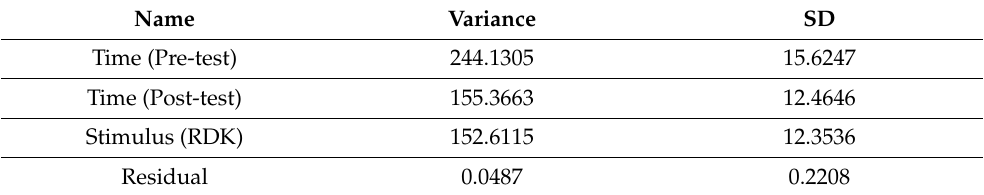
Table 2. Variance of the random